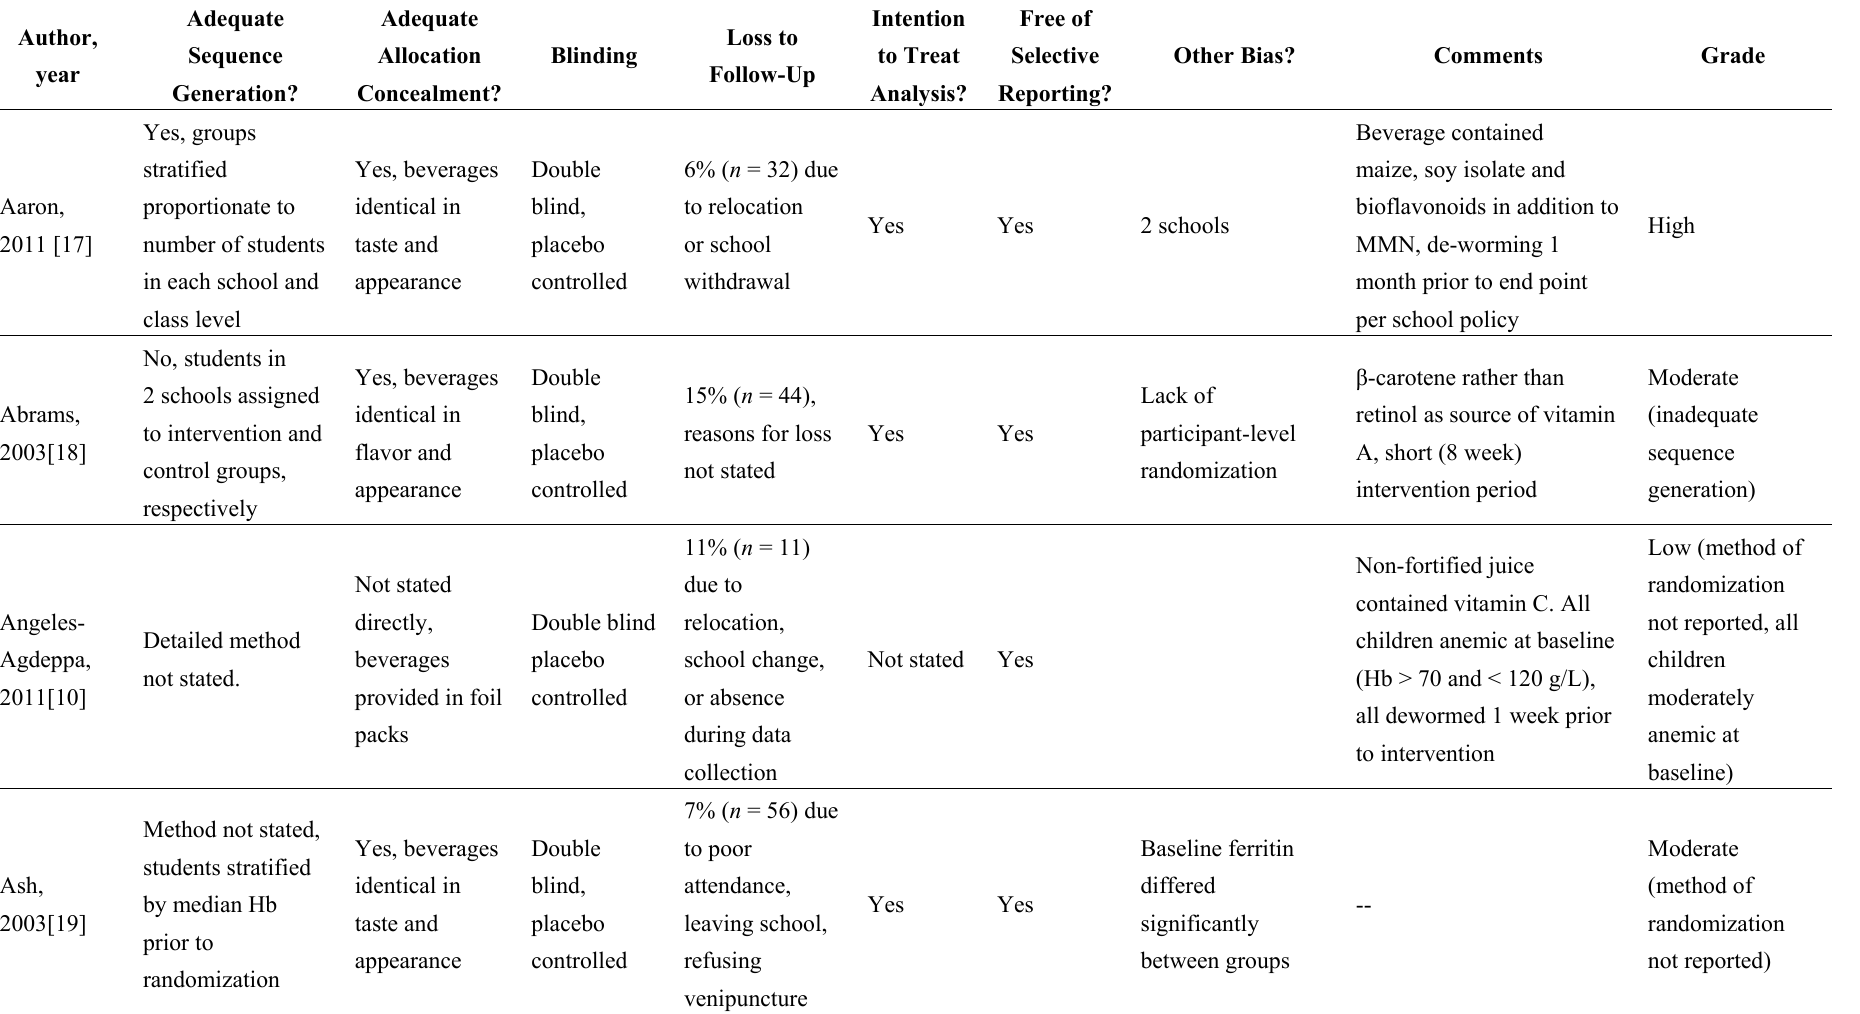
Table 3. Methodological quality of studies included in the